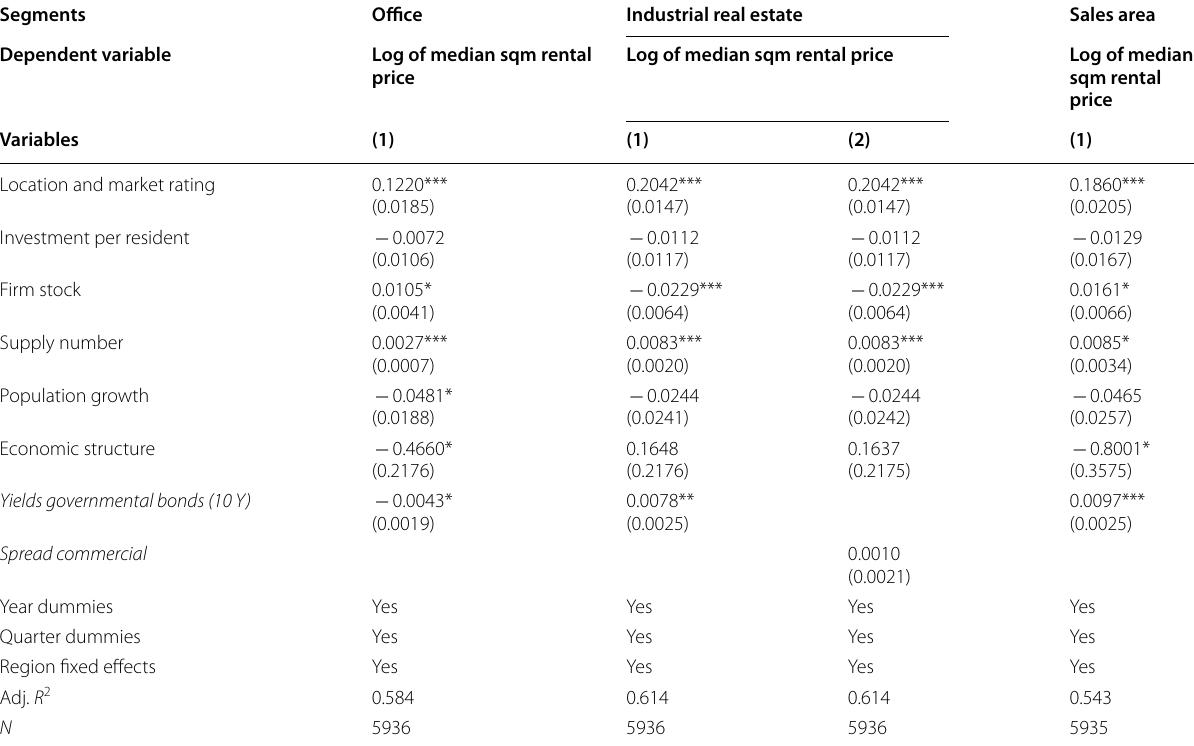
Table 7 Fixed-effect panel regression—commercial real